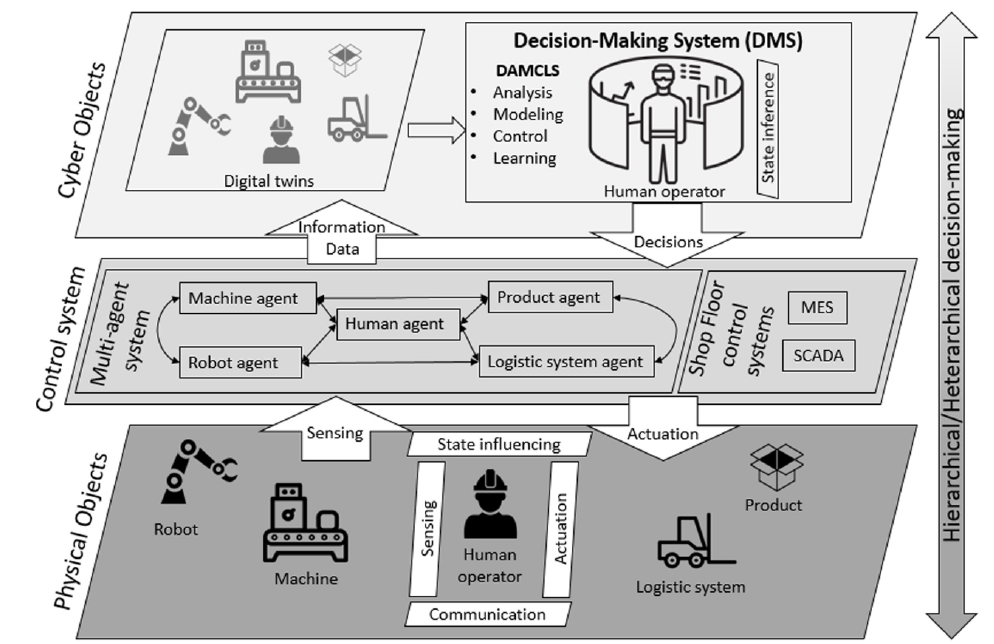
Figure 4. Three levels of the Cyber–Physical system in Industry 4.0